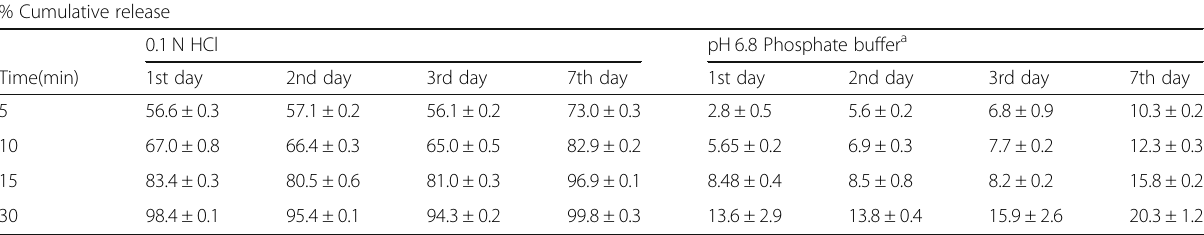
Table 5 In vitro release studies of reconstituted formulation F8 on day 1, 2, 3 and 7 of reconstitution